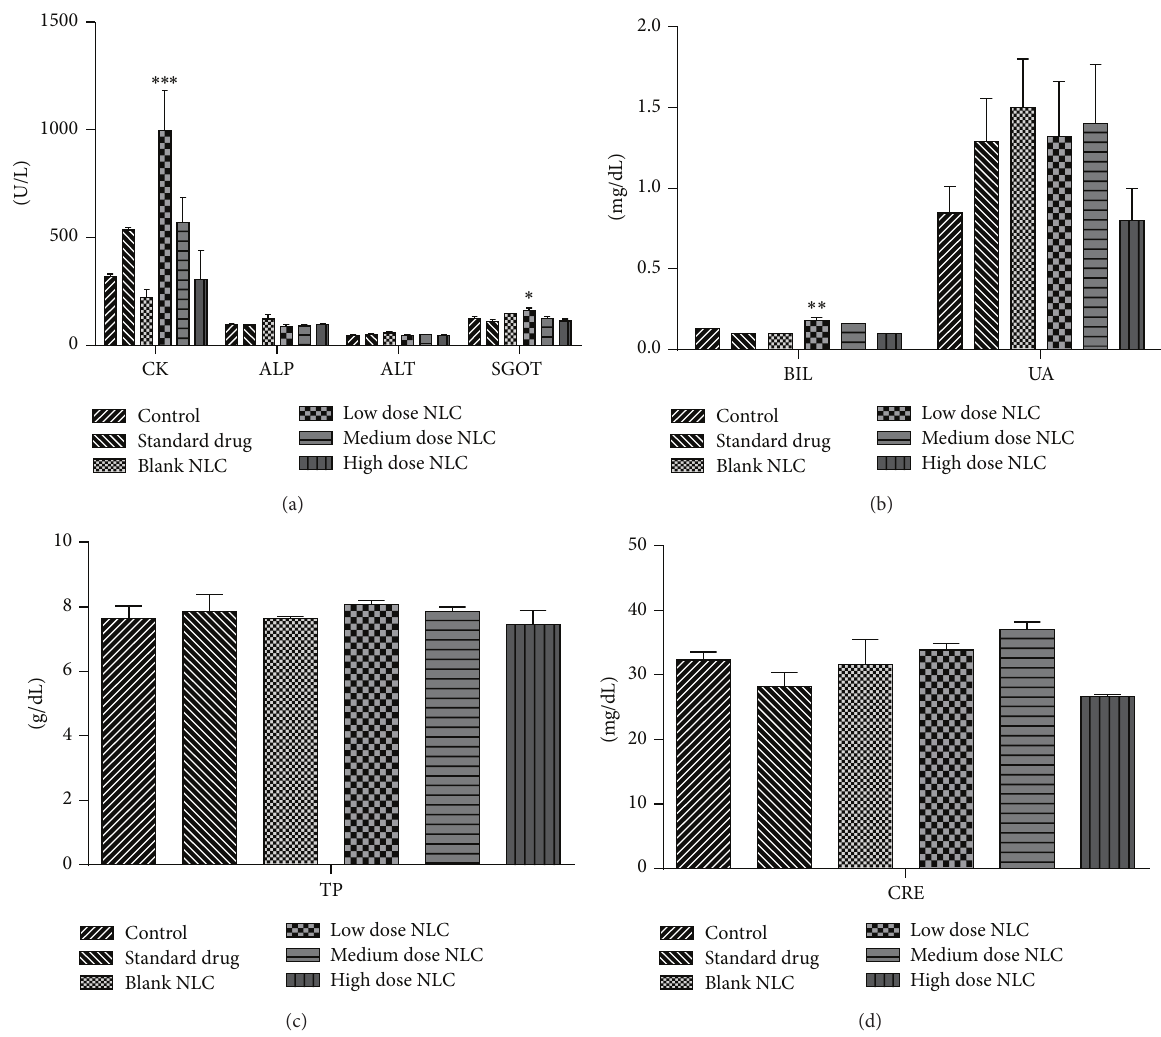
Figure 7: (a, b, c, and d) Clinical parameters of female rats treated with NLCs formulation. All the values are represented as mean ± SEM and 𝑛 = 5 . ∗ 𝑝 < 0.05 , ∗∗ 𝑝 < 0.01 , and ∗∗∗ 𝑝 < 0.001